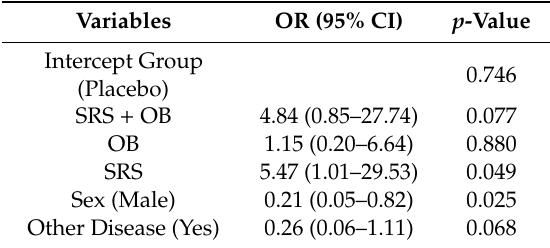
Table 5. Multiple logistic regression analysis of risk factors for symptom relief (ITT analysis).